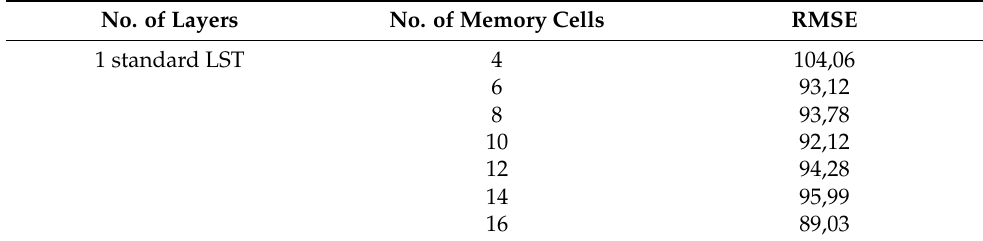
Table 8. Results for the different memory cells.